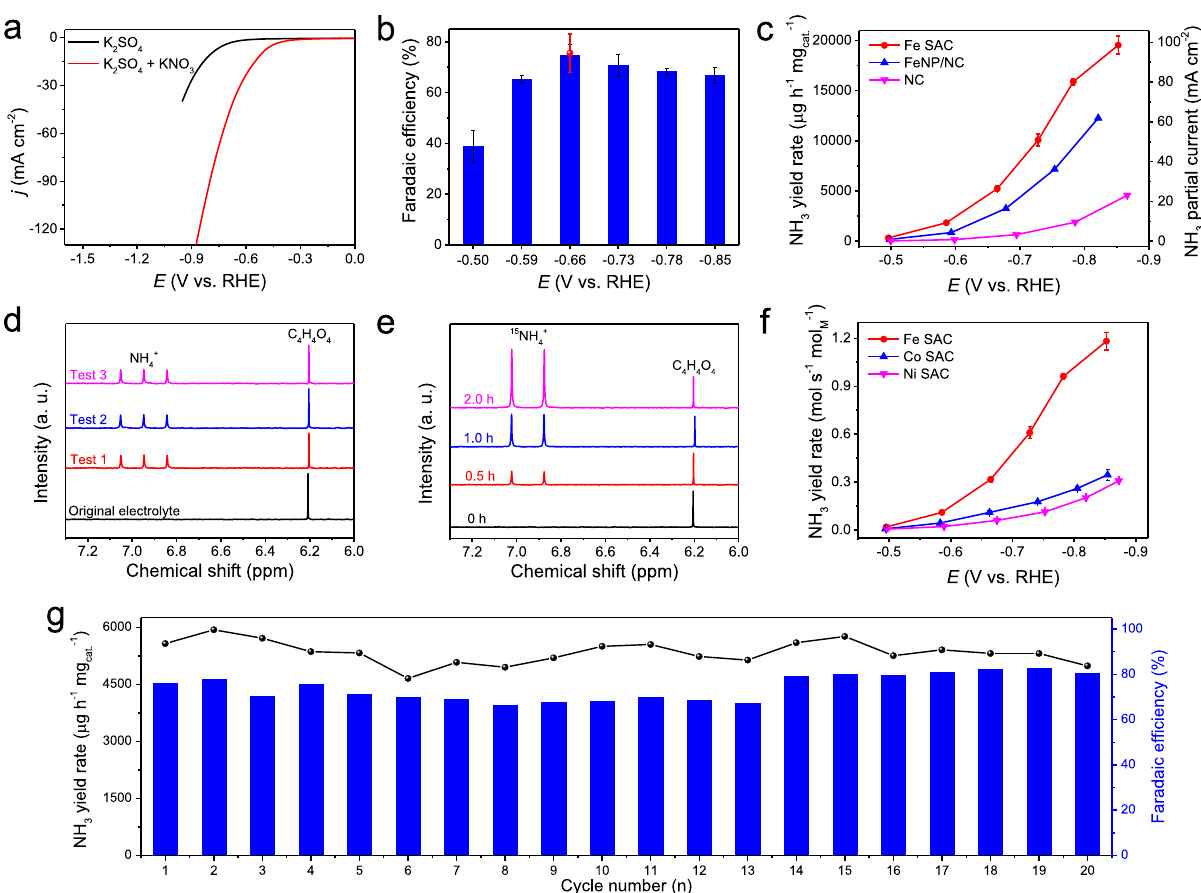
Fig. 3 Electrocatalytic nitrate reduction performance. a LSV curves of the Fe SAC in 0.25 M K 2 SO 4 electrolyte and 0.50 M KNO 3 /0.10 M K 2 SO 4 mixed electrolyte. b NH 3 FE of Fe SAC at each given potential. Red dot is FE estimated by three independent NMR tests. c NH 3 yield rate and partial current density of Fe SAC, FeNP/NC, and NC. d 1 H NMR spectra for the electrolytes after three independent nitrate reduction tests at − 0.66 V. e 1 H NMR spectra for electrolytes after 15 NO 3 – reduction tests at different time using 0.50 M K 15 NO 3 /0.10 M K 2 SO 4 mixed electrolyte. f NH 3 yield rate of Fe SAC, Co SAC, and Ni SAC based on metal content. g The cycling tests of Fe SAC for reduction tests at − 0.66 V. Catalyst loading for all of electrocatalytic nitrate reduction tests is 0.4 mg cm − 2